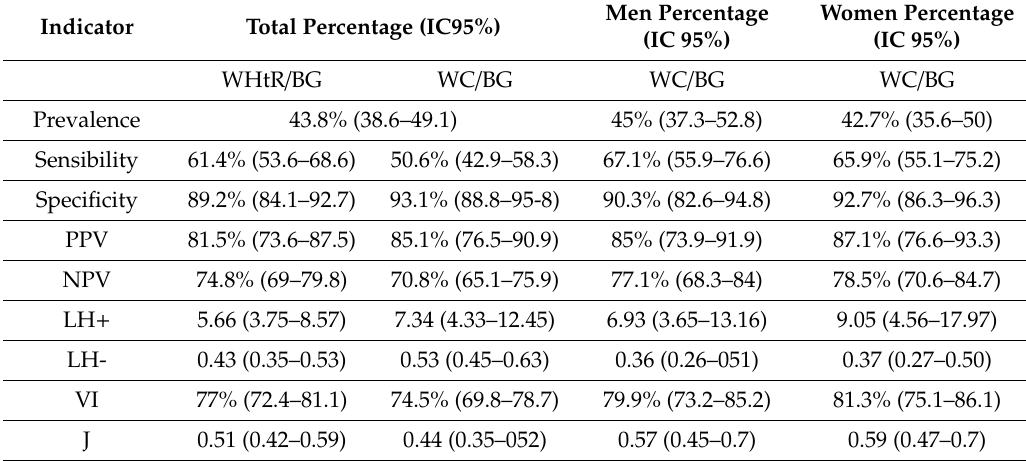
Table 3. Leading predictive indicators for the MetS diagnosis models in the elderly